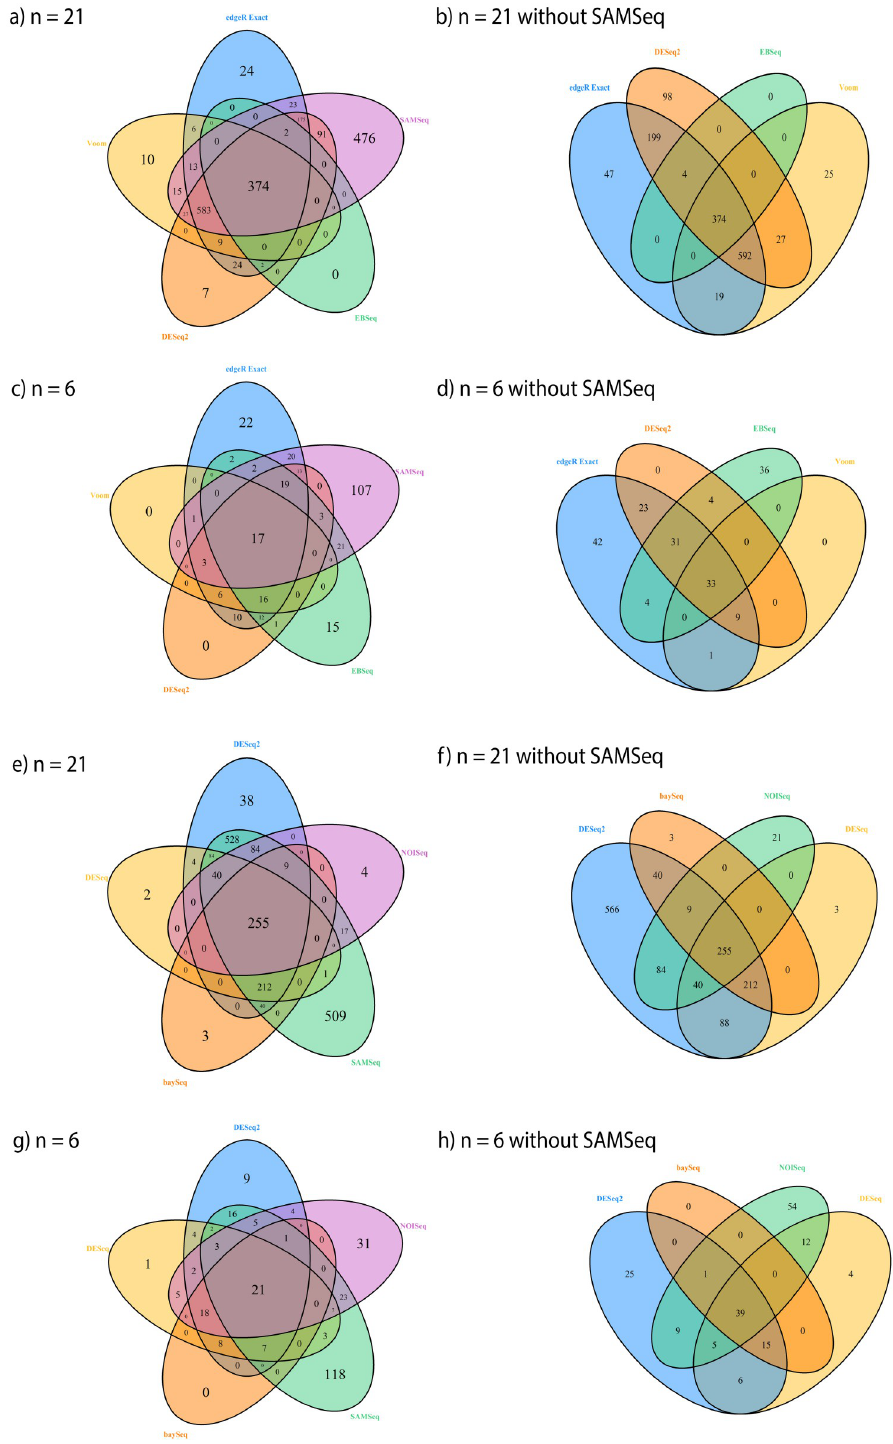
Fig 5. Venn diagram of selected significant genes from different RNA-seq differential analysis methods with 21 samples and randomly selected 6 samples. (a)-(d) use significant genes from the edgeR Exact, SAMSeq, EBSeq, DESeq2, and Voom methods; (e)—(h) use significant genes from the DESeq2, NOISeq, SAMSeq, baySeq, DESeq methods.